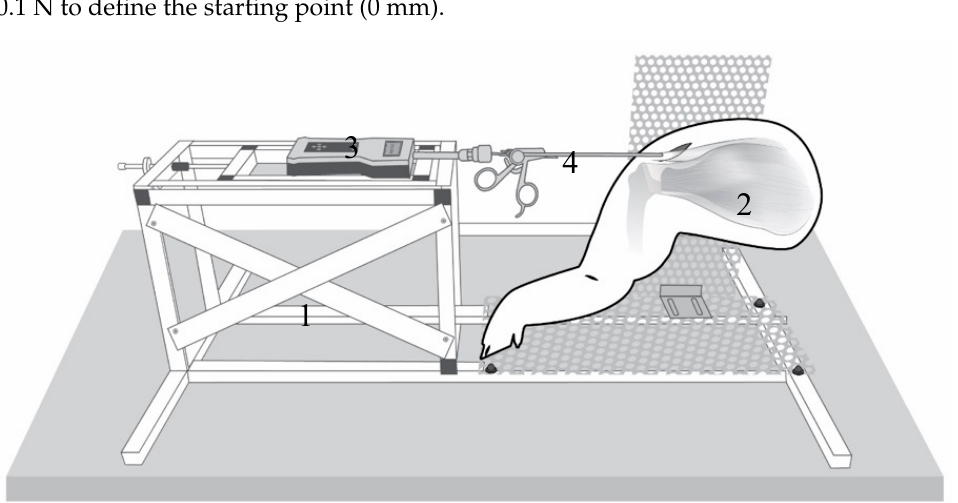
Figure 1. Testing station (1) with the porcine shoulder (2): The industrial force gauge (PCE-FB 200, accuracy ± 0.1%, precision 0.05 N, measuring range 0.5–200 N, Fa. PCE Instruments) (3) connection to a commercial arthroscopic grasper (4) (Rotator cuff grasper: 4.2 mm shaft diameter with traumatic